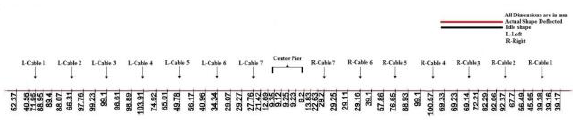
Figure 20: Cable Bridge deck linearity deflections In the figure 21, the bold black values corresponds to the deflection at the left cables, centre foundation support and right cables of the Cable Bridge. The maximum Beam bridge deck linearity deflection obtained is 103.91 mm shown in red at the